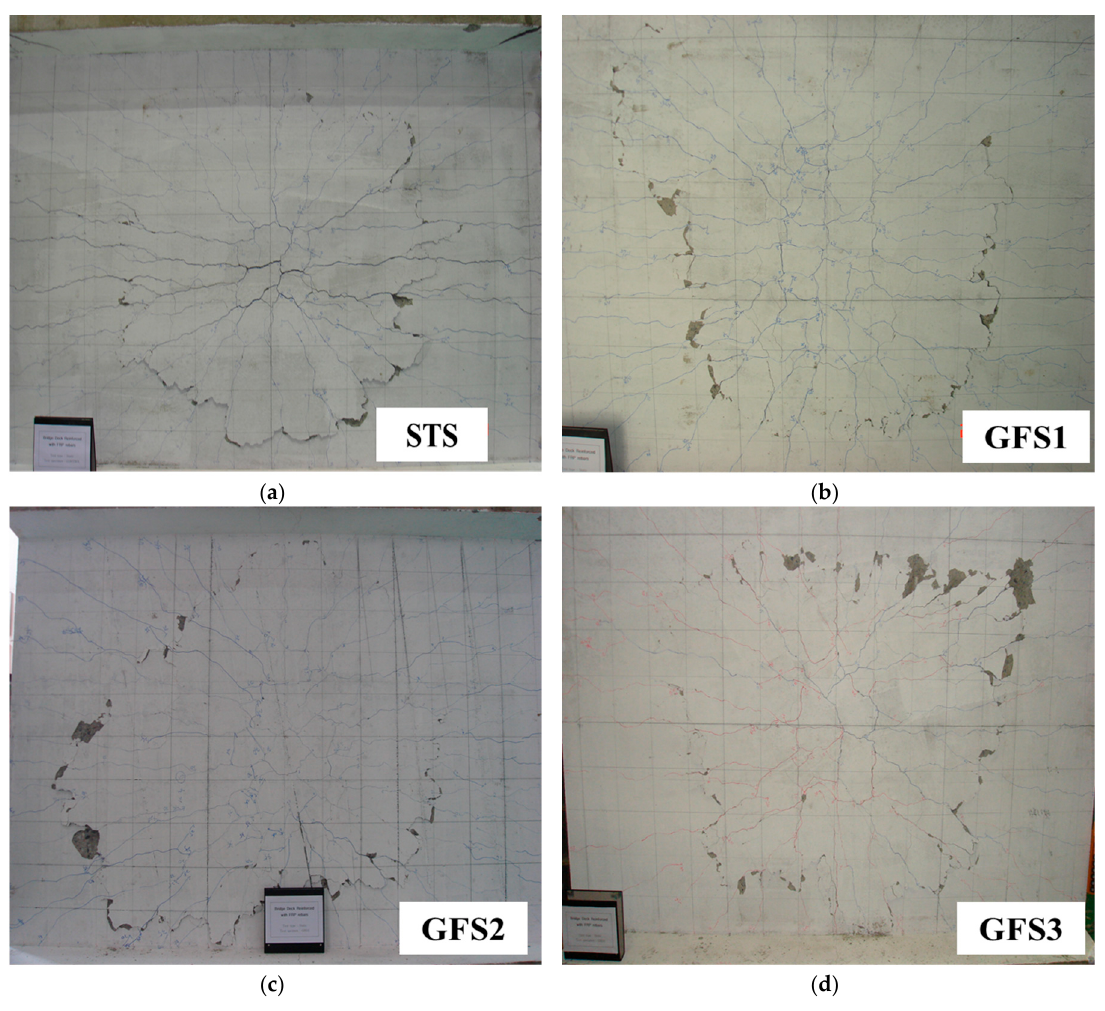
Figure 4. Punching shear failure at the bottom surface. ( a ) STS specimen; ( b ) GFS1 specimen; ( c ) GFS2 specimen; ( d ) GFS3 specimen.